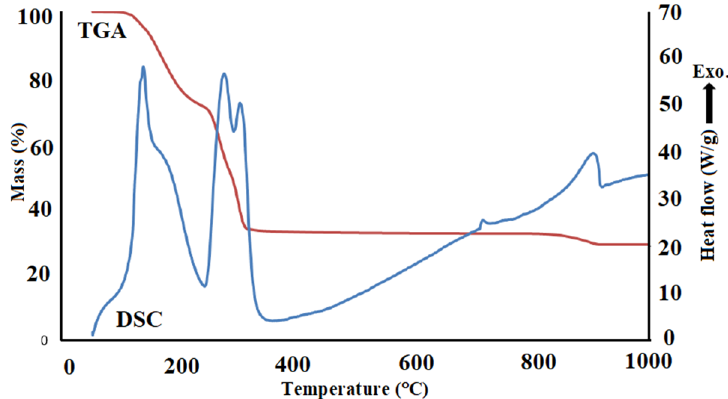
Figure 1. DSC-TGA analysis of AgNO 3 salt.